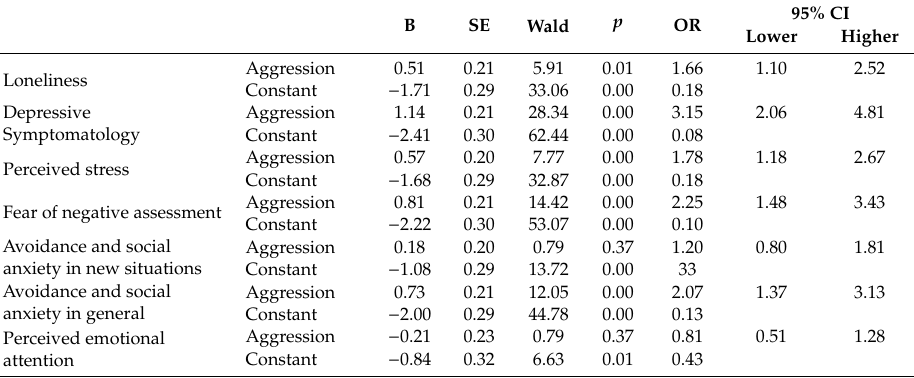
Table 2. Logistic regression with traditional aggression as a predictor of high